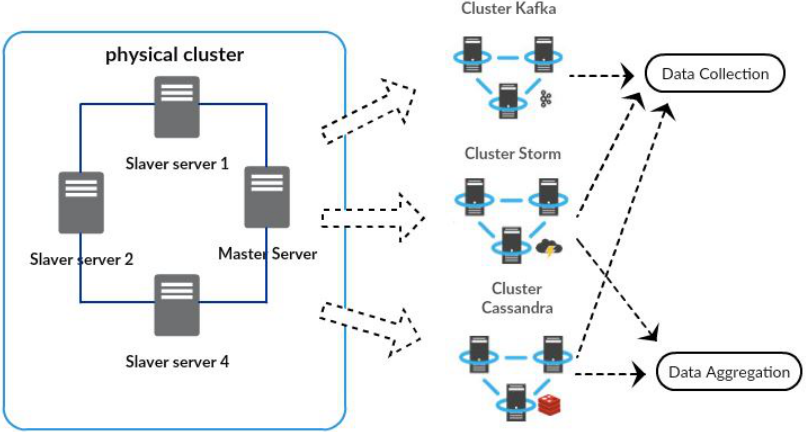
Figure 9. Computational environment of DDS.